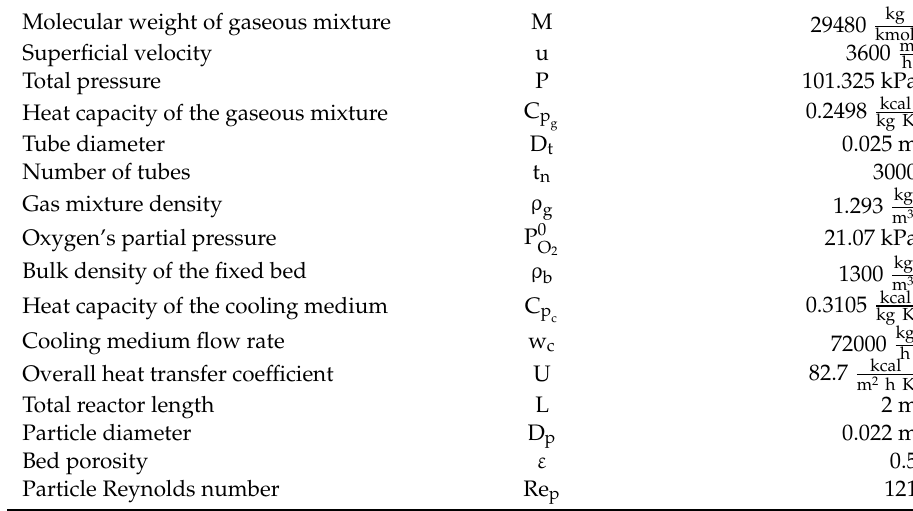
Table 2. Data used for the o-xylene oxidation simulation